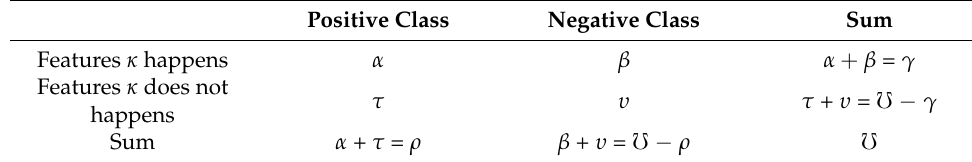
Table 2. Table for computing the χ 2 test